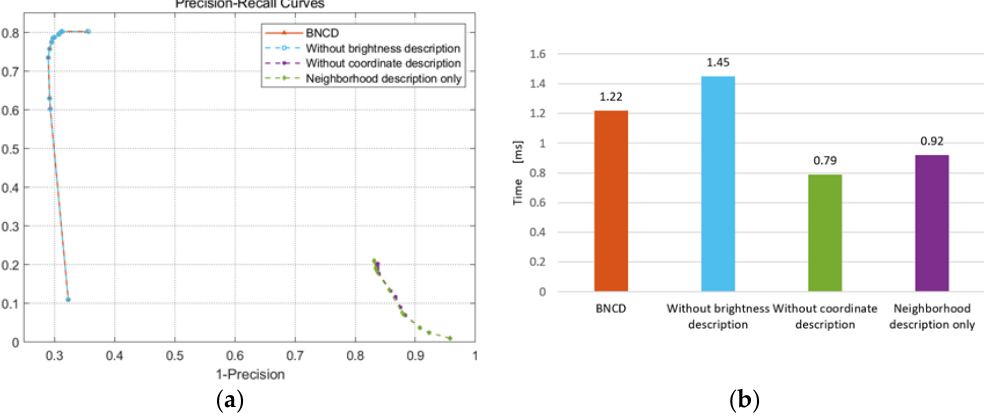
Figure 13. The influence of coordinate description and brightness description on BNCD. ( a ) Recall – precision curves. ( b ) Matching time.